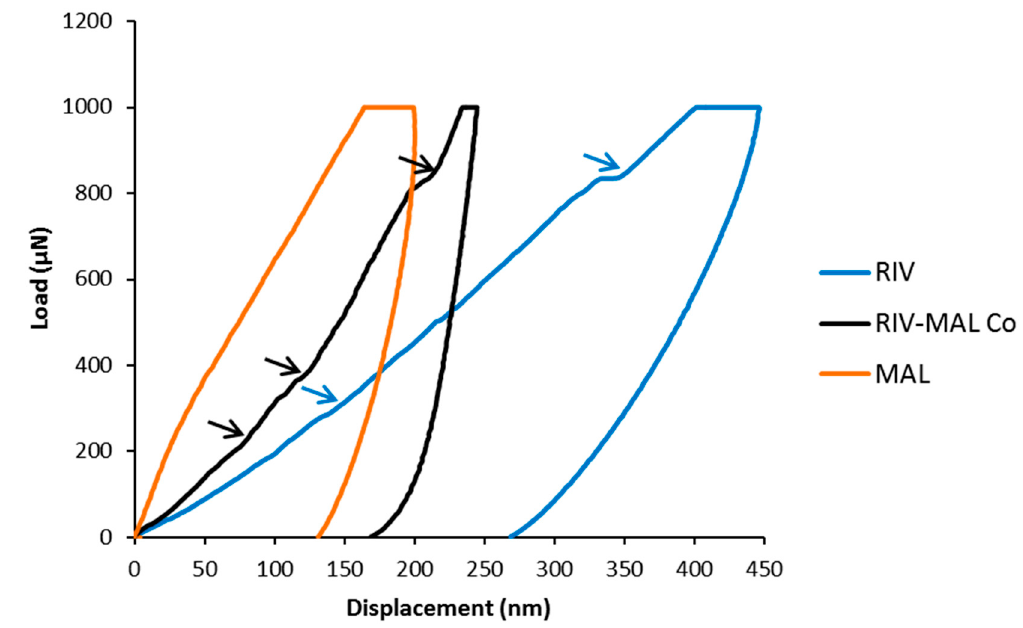
Figure 8. The load-displacement ( p ‒ h ) curve for RIV, MAL, and RIV-MAL Co. The pop-ins observed in crystal samples of RIV and RIV-MAL Co are shown by pointing “blue” and “black”, arrows,